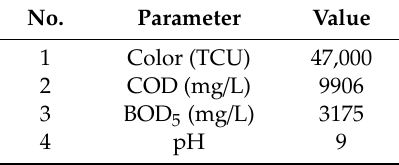
Table 4. Initial characteristics of sulphuric coloring agent of the textile industry. No.